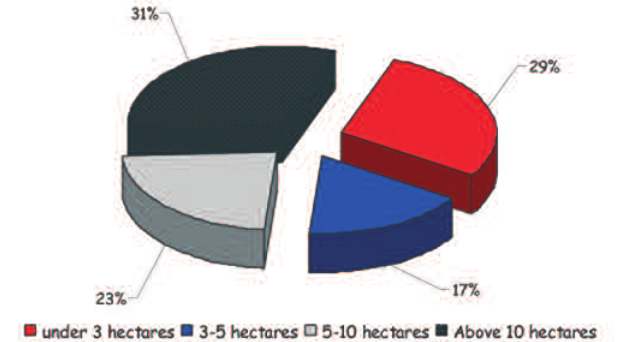
Figure 1. Distribution of surveyed farms upon the estate size in the distribution (%) of valid answers, 2009 Source: On the basis of empirical research,